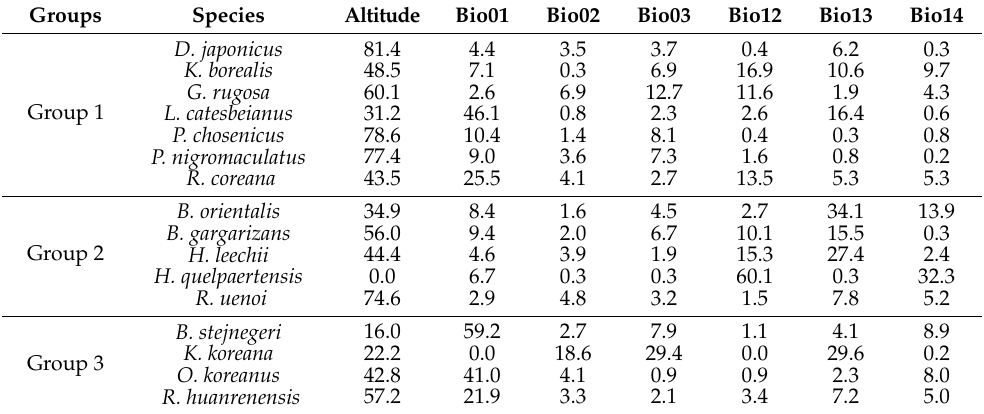
Table 3. Estimating the contributions of environmental variables for the modeling of 16 amphibian species among habitat groups.